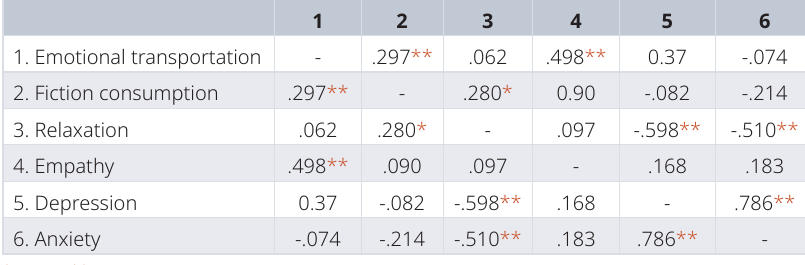
Table 3. Correlation between outcome variables and predictor variables.